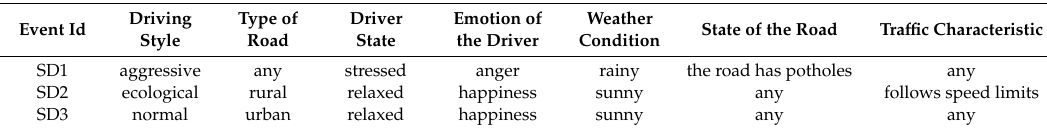
Table 4. Driving style [6].